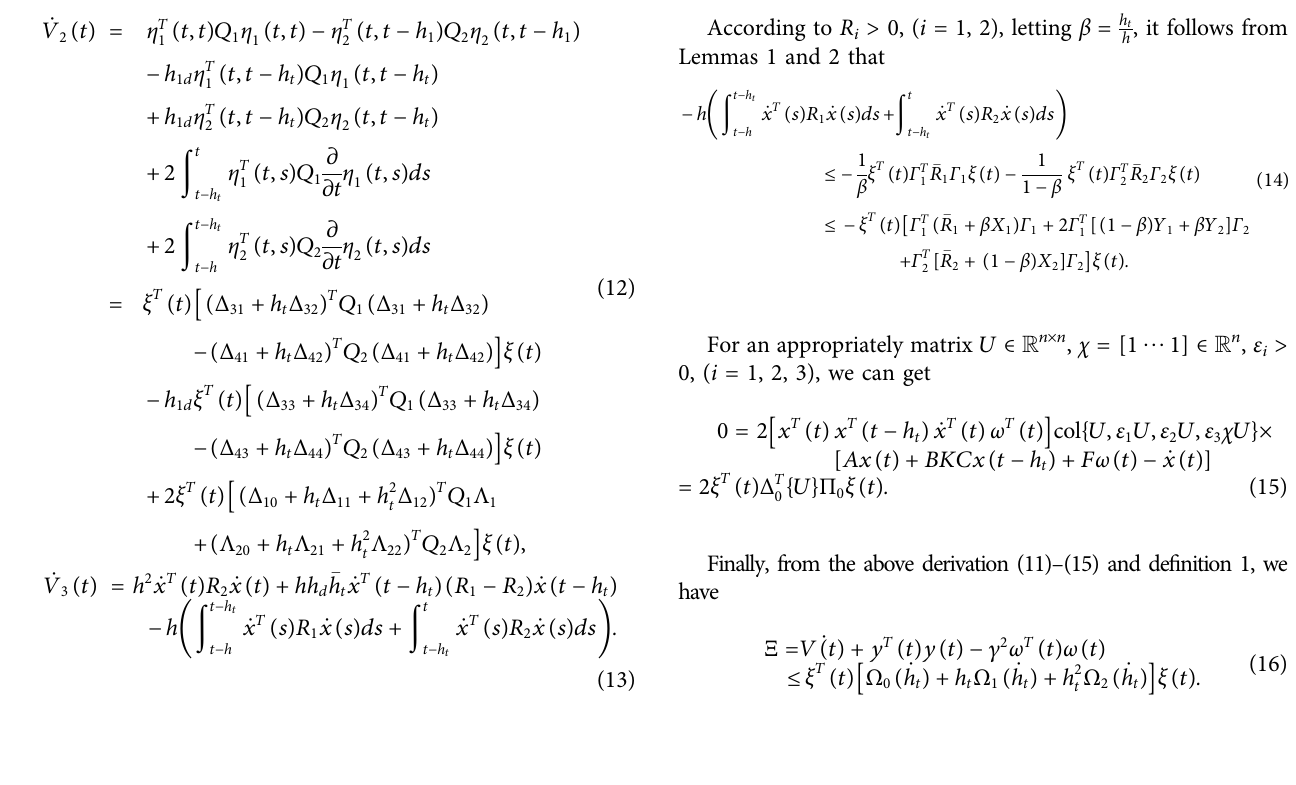
Frontiers in Energy Research |